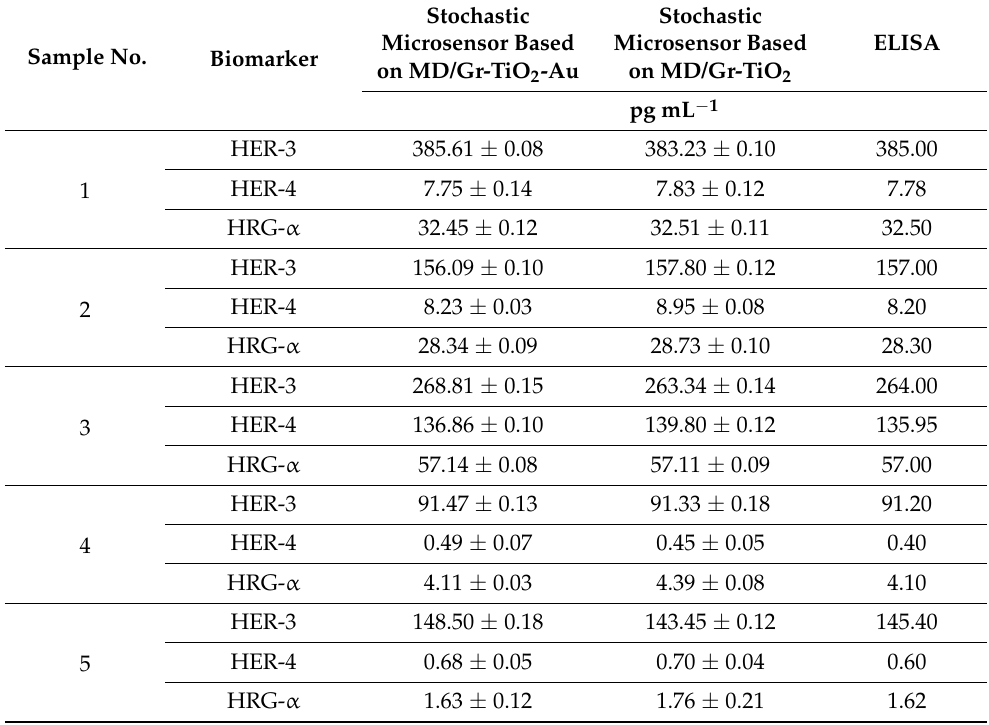
Table 3. Determination of HER-3, HER-4 and HRG- α in whole blood samples.